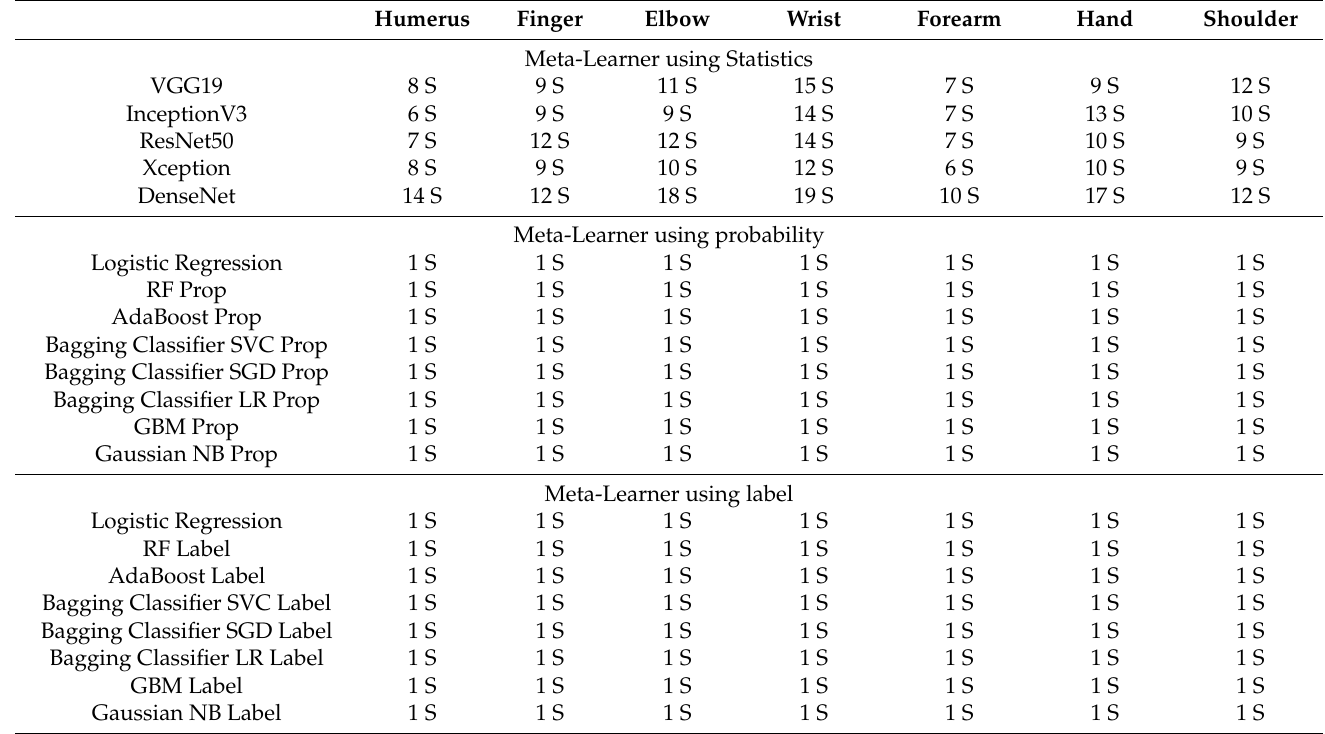
Table A10. The Average Testing